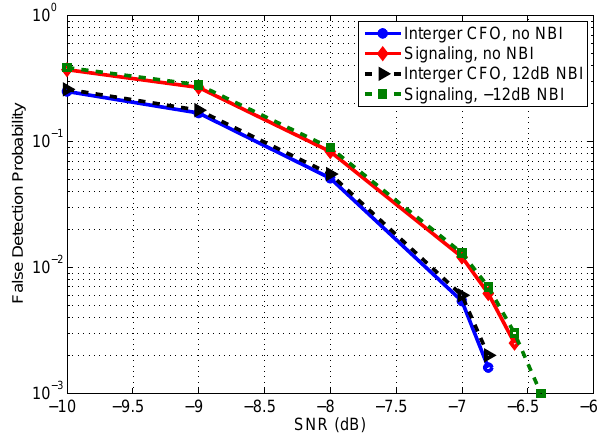
Figure 8. False probability of integer CFO estimation and signaling